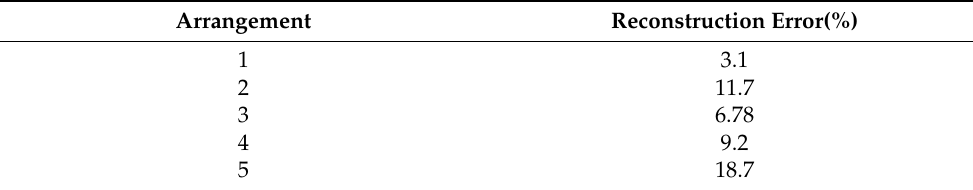
Table 2. Reconstruction errors with different sensor